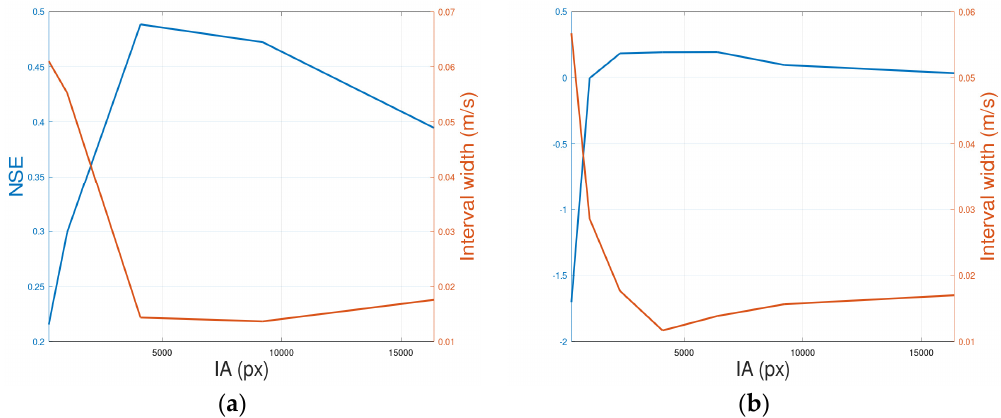
Figure 6. The impact of the mean IA size ( L × L ) on the accuracy of the estimated velocities and the 90% confidence interval width for Video B and the cross-sections S1 ( a ) and S2 ( b ).